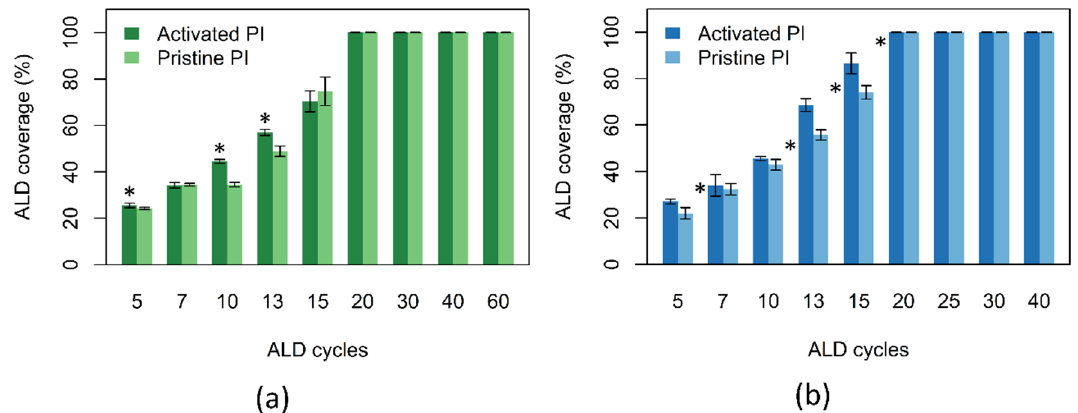
Figure 4. Estimated coverage of polyimide as the nucleation of ( a ) Al 2 O 3 ALD and ( b ) HfO 2 ALD evolved. The coverage was calculated on both pristine and plasma-activated polyimide. * Denotes a statistically significant difference between the coverage values of identical number of ALD cycles on pristine and plasma-activated polyimide at a significance level of 0.05.